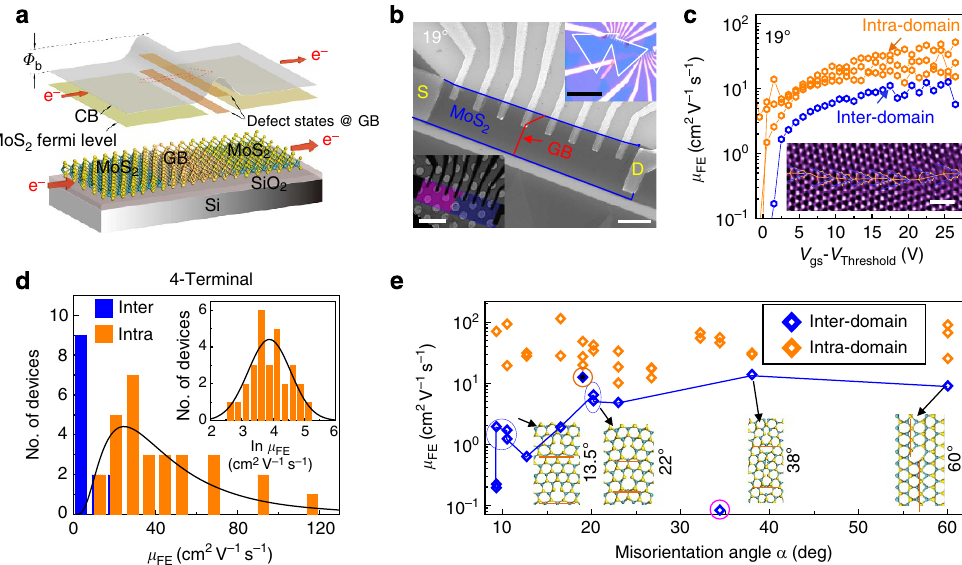
Figure 1 | Measurements and statistics on Intra-domain vs inter-domain transport. ( a ) Experimental schematic of carrier transport across a grain boundary. ( b ) SEM image of a device sample on SiO 2 /Si wafer; scale bar, 3 m m. After device characterization, the device was transferred to a TEM grid; scale bar, 6 m m (left inset). Right inset: Optical micrograph of the device with pre-etch flake shape outlined; scale bar, 30 m m. ( c ) Electrical performance of the device in panel ( b ) with a ¼ 19 (cid:2) . Intra-domain regions always have a higher m FE and reduced R S when compared to inter-domain. An STEM image of the boundary is shown in the inset. Inset scale bar, 1nm. ( d ) Statistical distribution of the intra- and inter-domain mobilities with m FE(inter) o 16cm 2 V (cid:2) 1 s (cid:2) 1 o m FE(intra) . The intra-domain m FE displays a log-normal distribution (black line) with expectation value m FE ¼ 44cm 2 V (cid:2) 1 s (cid:2) 1 , as exemplified by ln( m FE ) in the inset. ( e ) The a -dependent m FE(inter) (blue) for 10 different angles with m FE(intra) (total of 43 devices). Here, m FE(inter) increases with a rise in a from 9 (cid:2) to 20 (cid:2) , but saturates for a 4 20 (cid:2) at m FE(inter) o 16cm 2 V (cid:2) 1 s (cid:2) 1 . The 19 (cid:2) dislocation is of the ‘Down’-type, while the others are